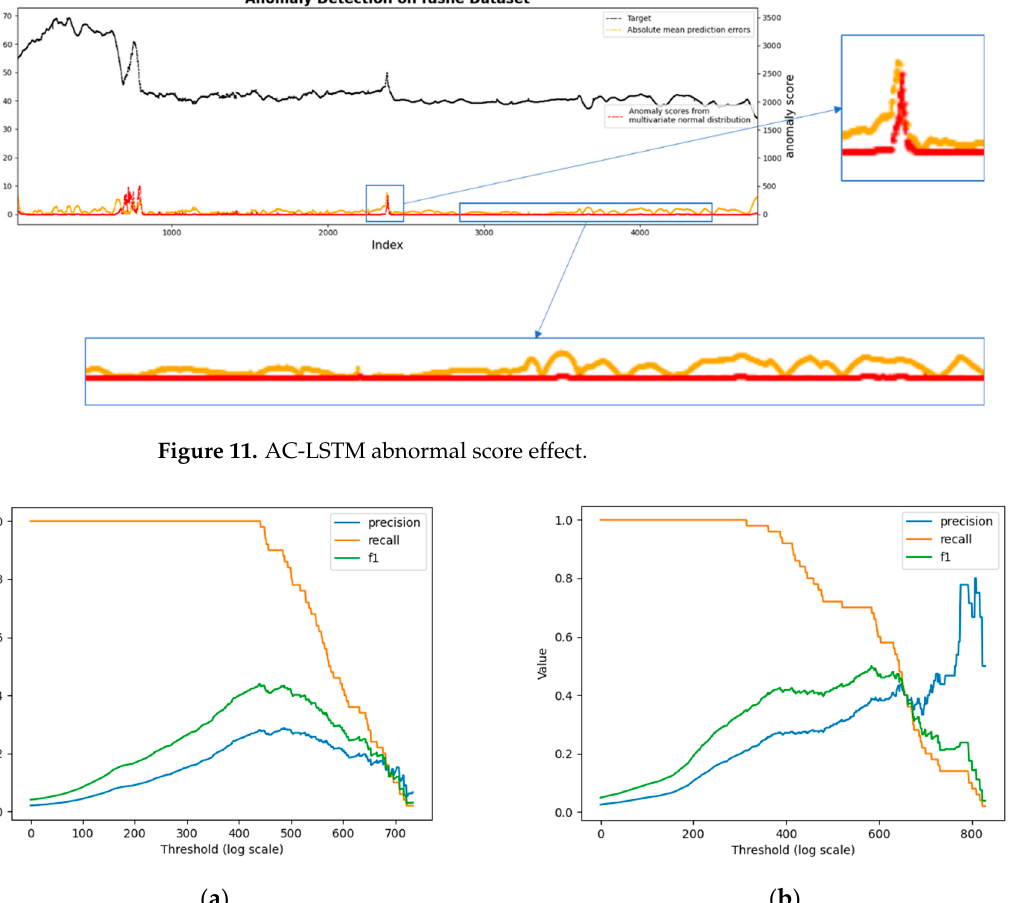
Figure 12. The curve of Precision, Recall, and F1 Score. ( a ) The effect of using LSTM alone for anomaly detection. ( b ) The effect of anomaly detection using AC-LSTM proposed in this paper.